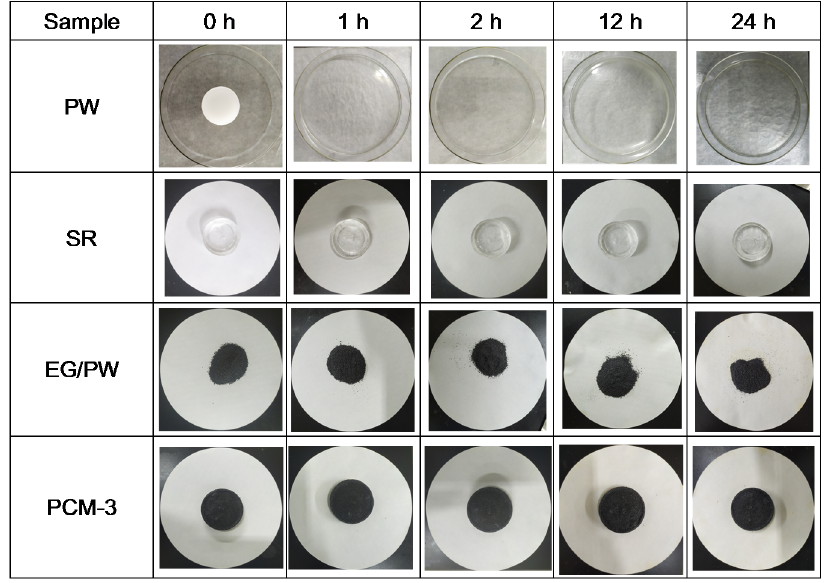
Figure 7. Optical photographs of PW, SR, EG/PW and PCM-3 deposited at 150 °C for 24 h.